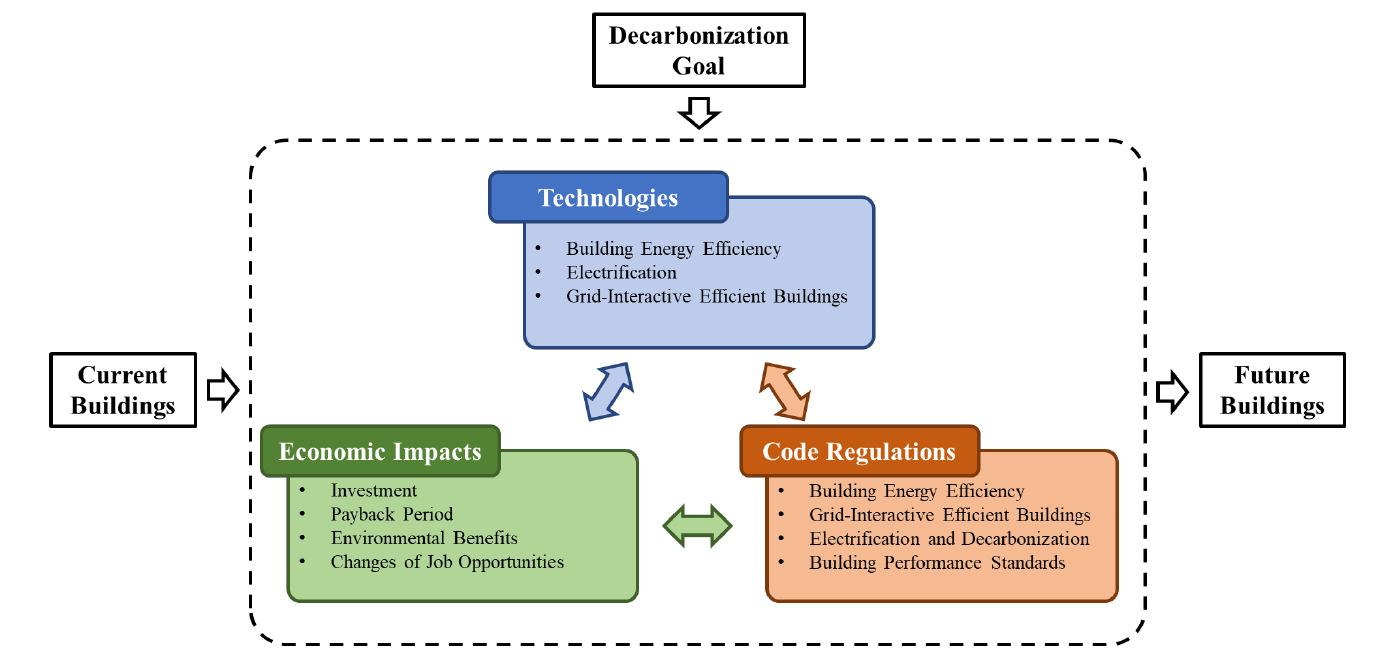
Figure 1. Theory for building decarbonization research.